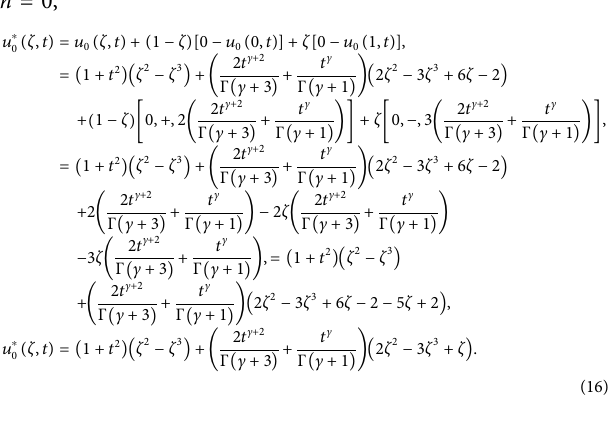
FIGURE11| Comparison forthe exactand analyticalsolution at γ =1 for Example 3.